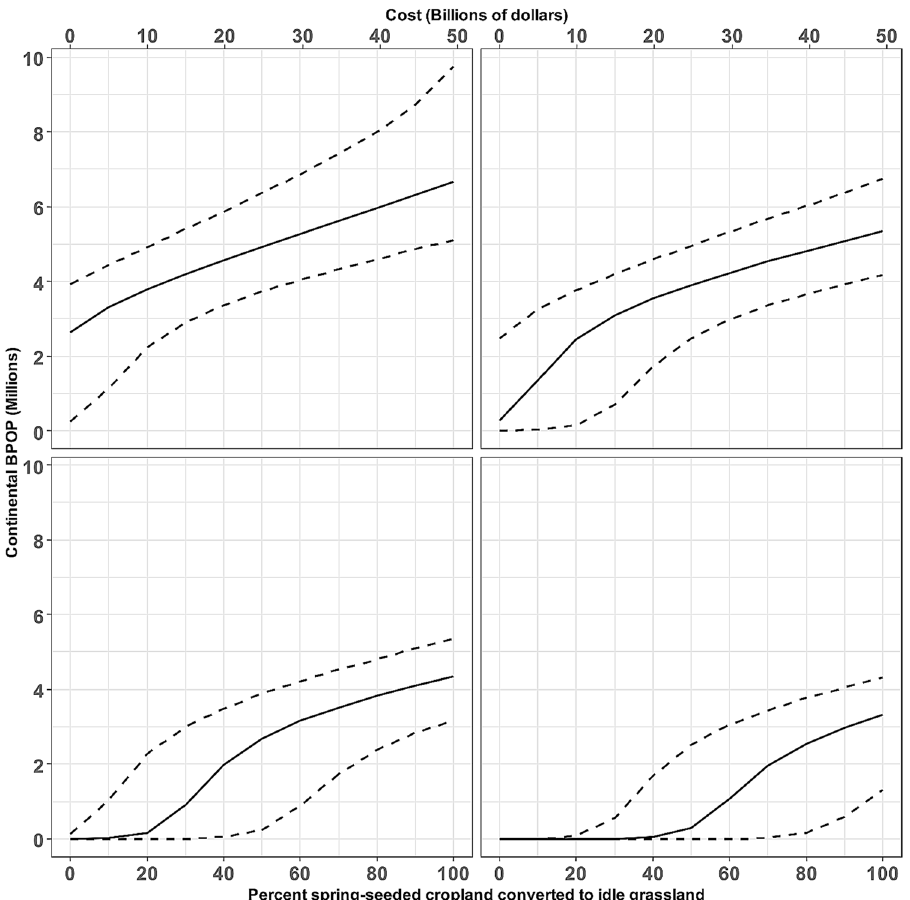
Figure 3. Predicted relationship between conversion of spring-seeded cropland to idle grassland within the Prairie Pothole Region and the equilibrium population size of northern pintails at the start of the breeding season. The population size at the x-intercept (i.e., % converted = 0) corresponds with the Increase Winter Wheat scenario. Panels represent predicted relationships under particular proportions of all pintails harvested (i.e., harvest rate; h ). A harvest rate of zero represents a closed hunting season, and the remaining represent the uncertainty about harvest rate expected under a bag limit of one pintail. Cost of habitat conversion (secondary x-axis) is given in 2016 USD. Solid line is based on mean values for all parameters, and the dashed lines are based on the upper and lower 95% confidence intervals for parameters derived from available empirical